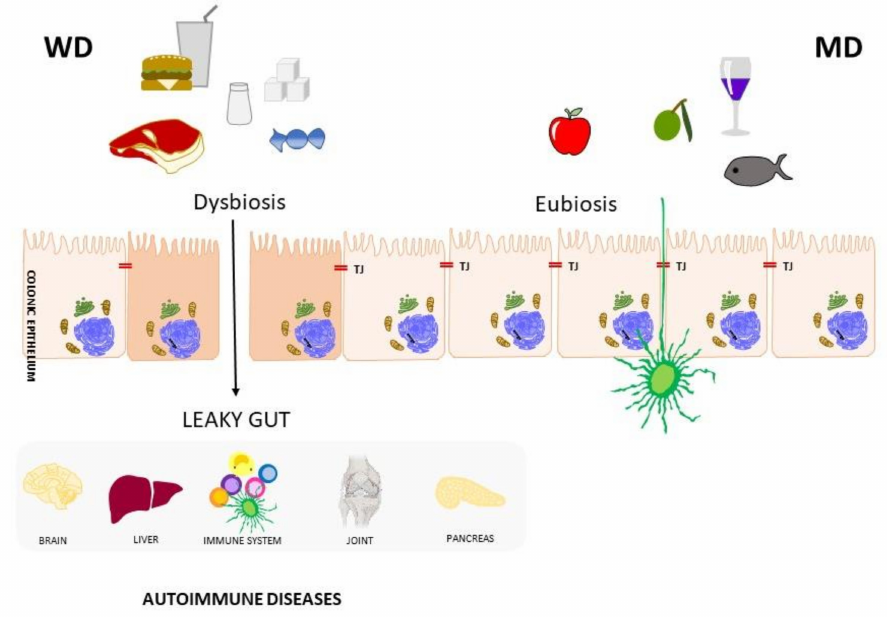
Figure 1. Western diet and Mediterranean diet impacts on gut microbiota homeostasis and intestinal integrity. A leaky gut condition promotes local and systemic